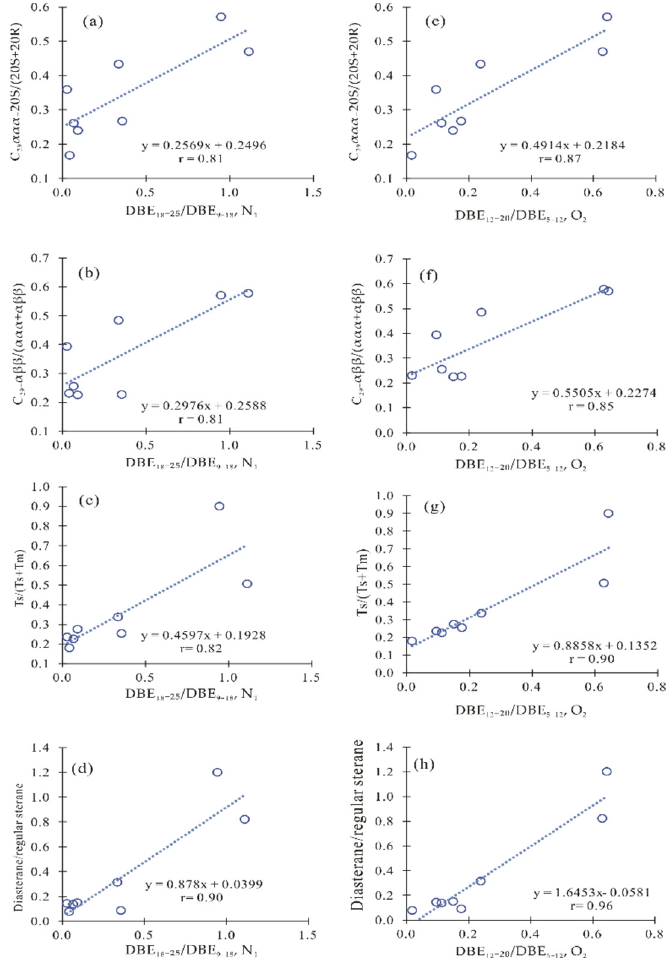
Figure 11. Relationship between the N 1 - and O 2 -, ratios (DBE 18–25 /DBE 9–18 , N 1 ; DBE 12–20 /DBE 5–12 , O 2 ) that were revealed by FT-IC MS and conventional maturity parameters. ( a – d ) show the relationship between DBE 18–25 /DBE 9–18 N 1 and C 29 ααα -20S/(20S + 20R), C 29 αββ / ααα + αββ , Ts/(Ts + Tm) and Di- asterane/regular sterane, respectively. ( e – h ) show the relationship between DBE 12–20 /DBE 5–12 , O 2 and C 29 ααα -20S/(20S + 20R), C 29 αββ / ααα + αββ , Ts/(Ts + Tm) and Diasterane/regular sterane, respec-